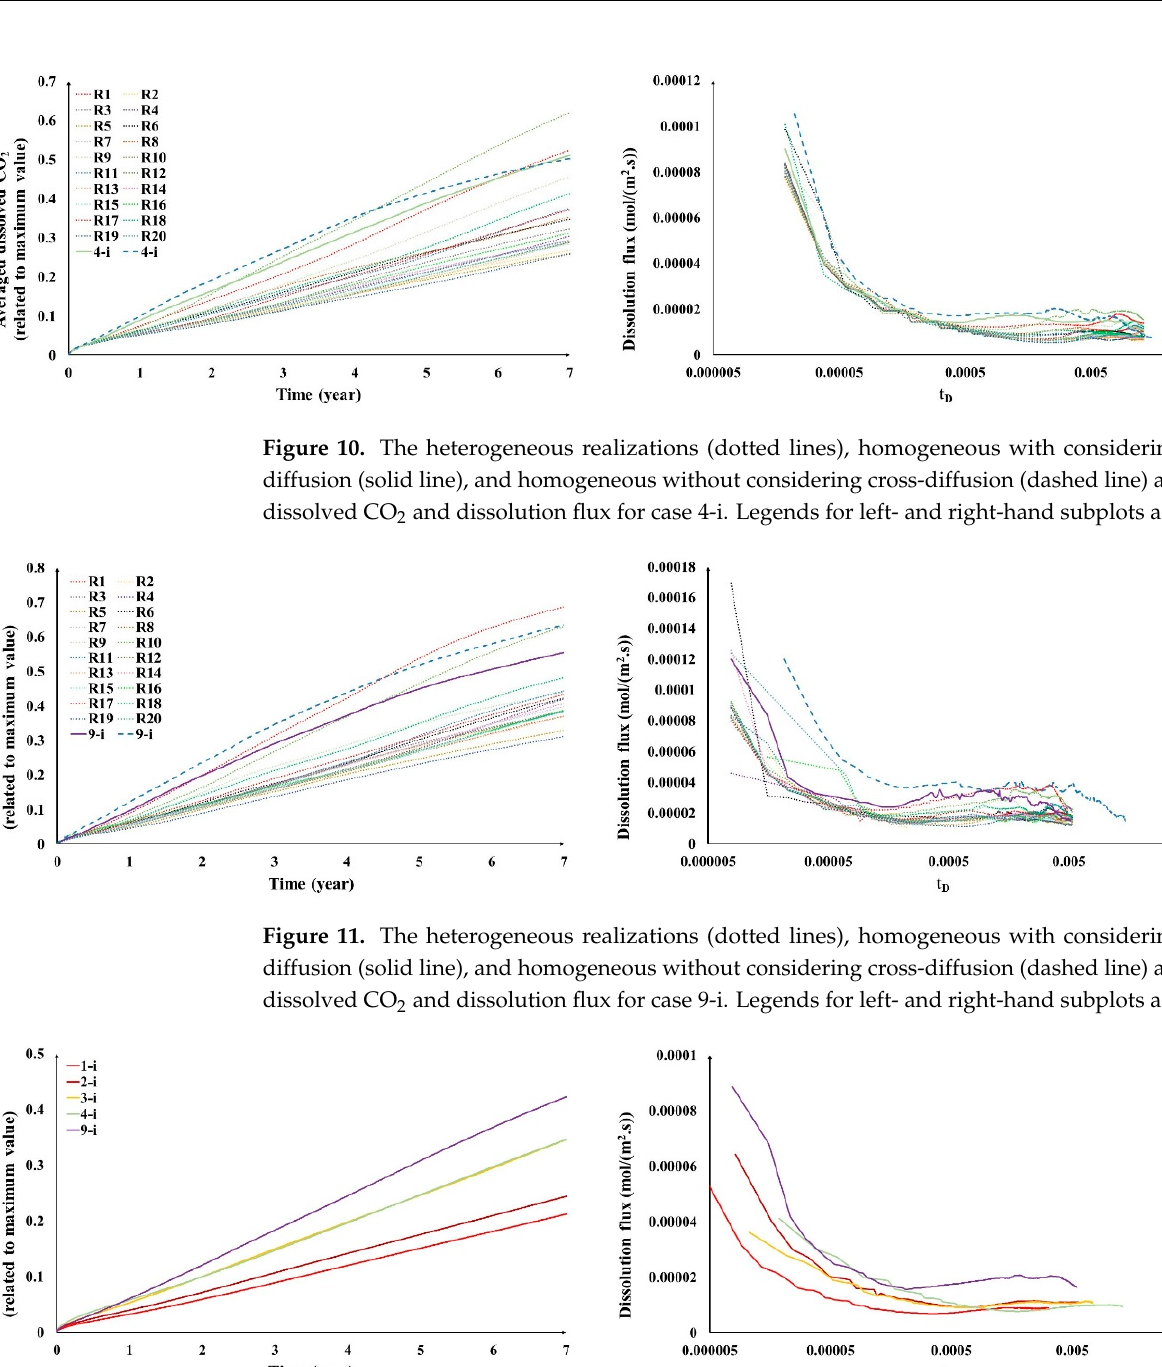
sion (solid line), and homogeneous without considering cross-diffusion (dashed line) averaged dis-